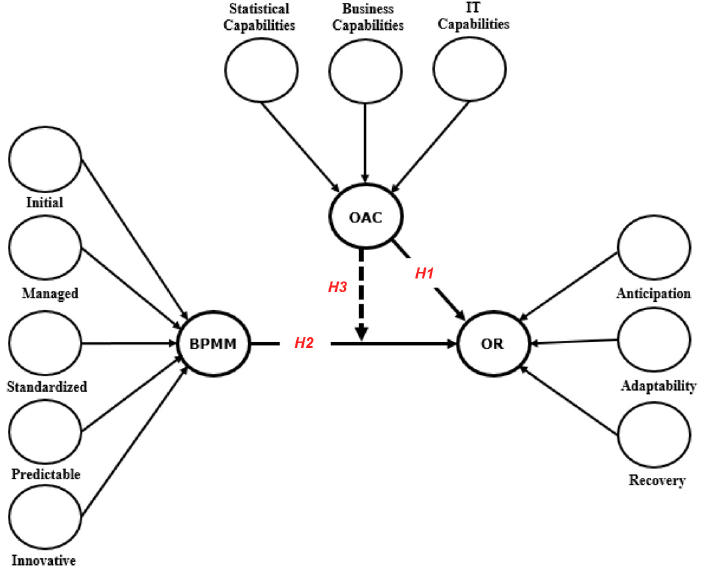
Figure 1. Research model and